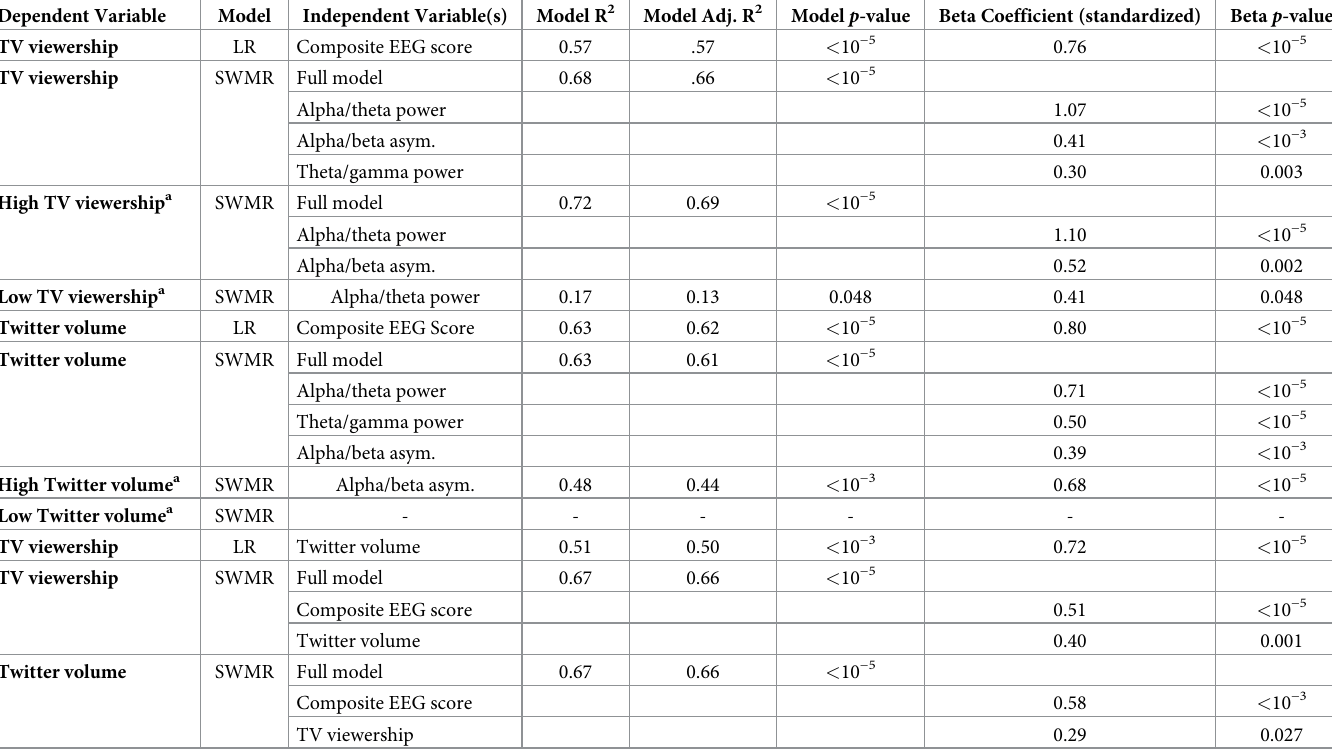
Table 2. Regression results predicting TV viewership and Twitter